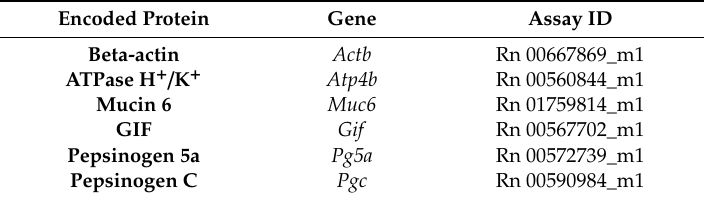
Table 2. Taqman ® probe assays used for detection of gene expression after